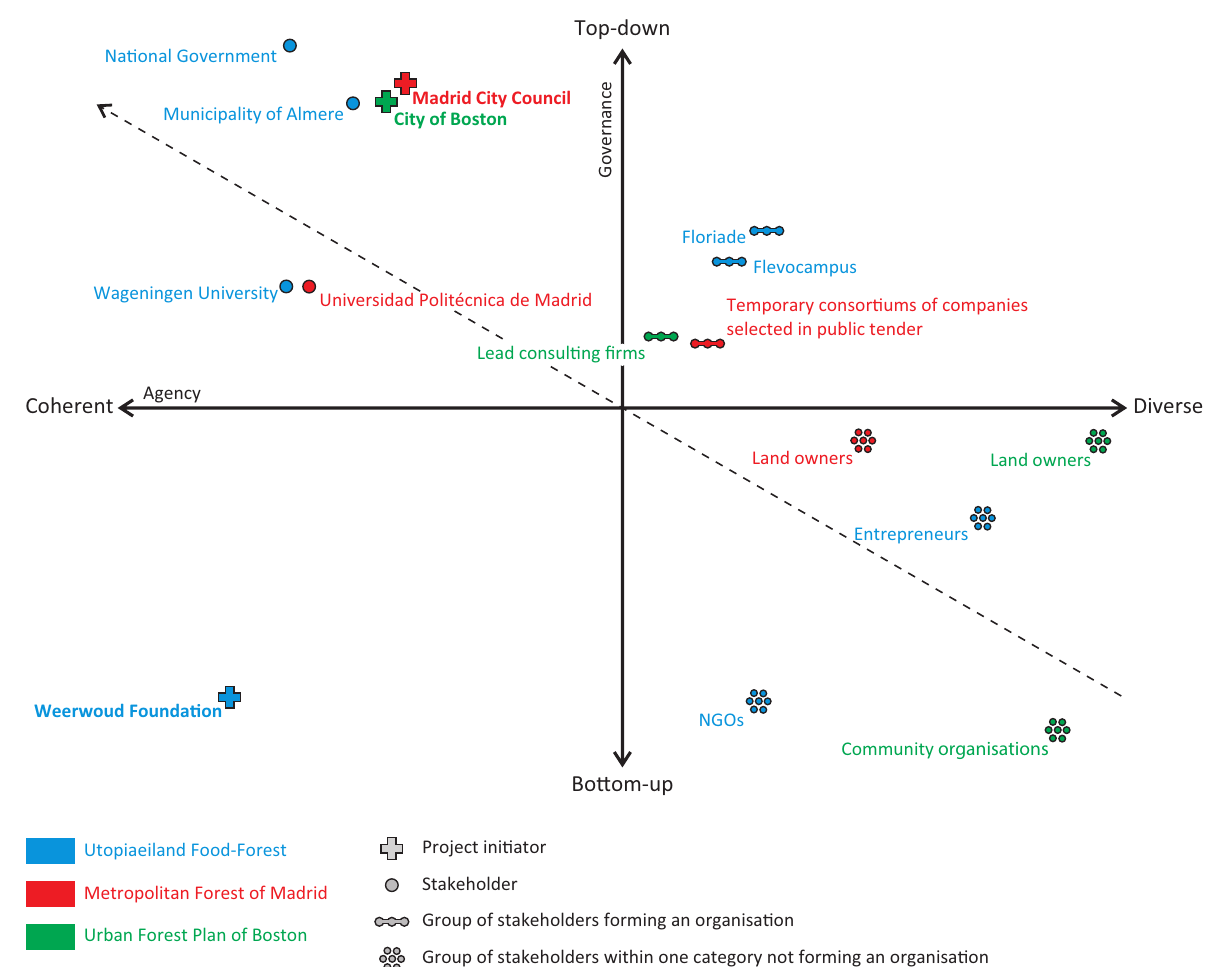
Figure 2. Characterization of the organisational form of the case studies. implementation is characterized by its dependency on single, coherent, bottom‐up leadership, and low levels of involvement of actors at the top. Therefore, such a governance model highlights possible collaborative and continuity challenges, which may affect the mainstream‐ ing and scaling‐up of the model. The Metropolitan Forest of Madrid can be characterized not just as top‐down, but also as a project mostly organised around a set of very coherent actors with regard to their